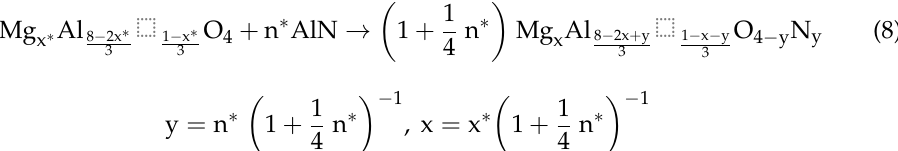
This reaction starts at temperatures of around 950 to 1150 °C [19,23,68,69]. Accord- tering time of 3 h, whereas the amount of MgO remaining after 6 h was practically zero (see Table S1). This observation indicates that the formation of MgAl 2 O 4 consumes almost any MgO present in the starting mixture. The Al 2 O 3 /AlN ratio of the mixture plays a sec- ondary role for the conversion degree [23,70]. With increasing temperatures, the homoge-